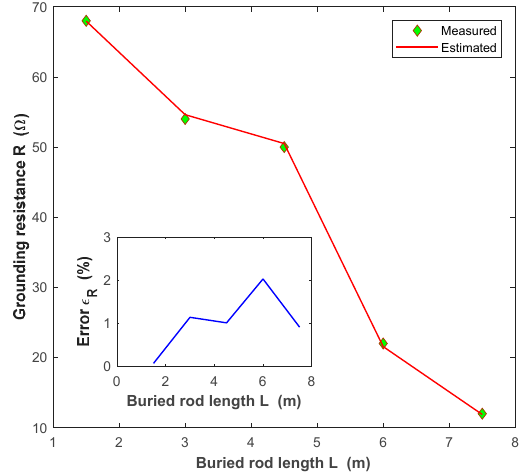
Figure 8. Measured and calculated grounding resistance in Girona.